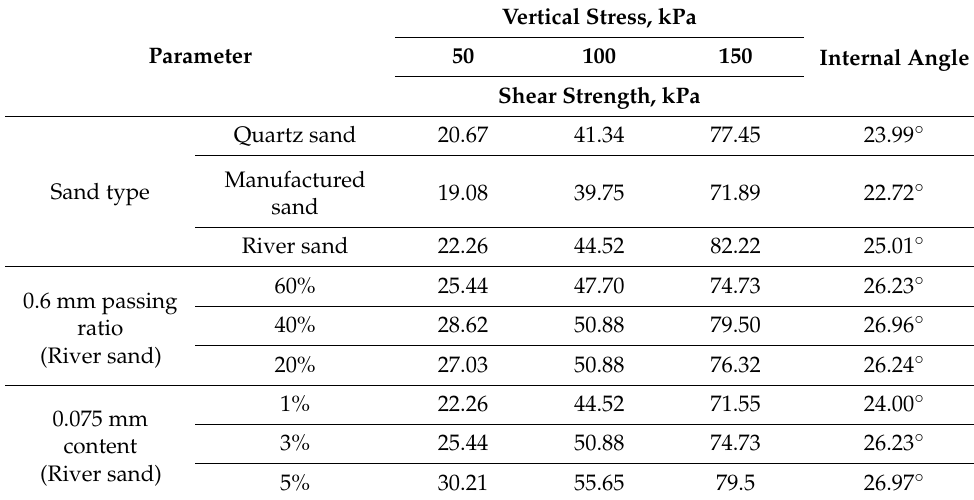
Table 4. Shear strength and internal friction angle according to sand type.